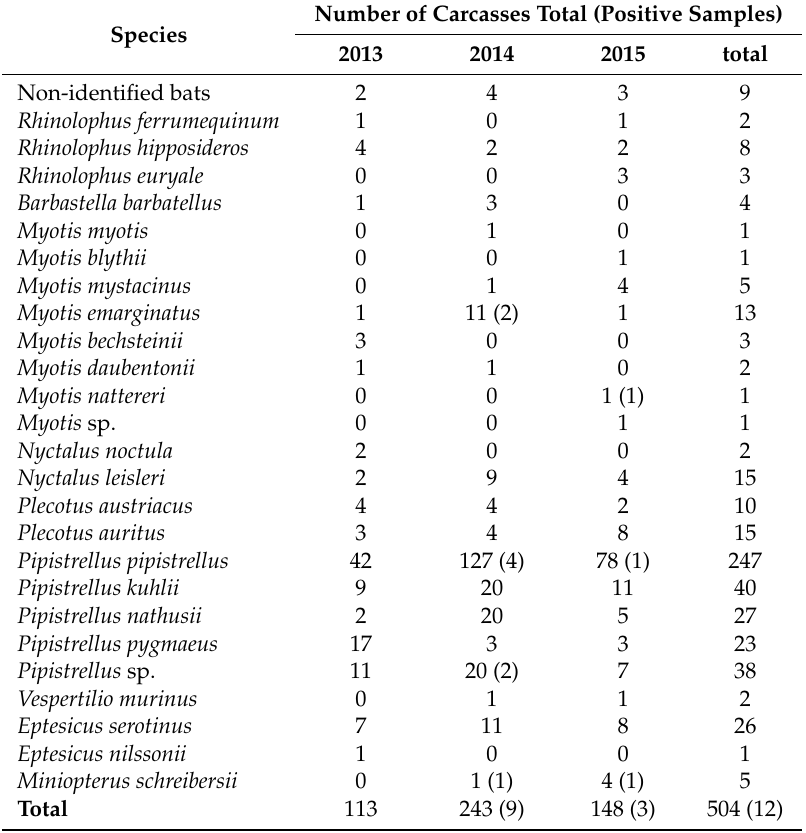
Table 1. Species of analyzed bats by year and by positive sample.